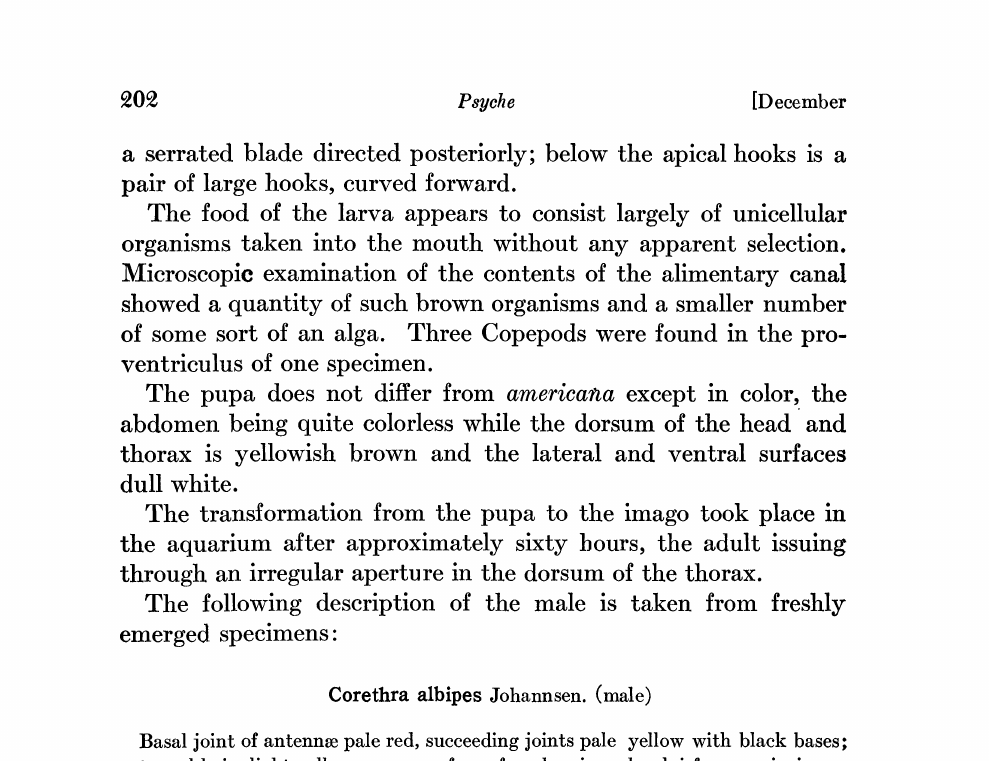
Corethra albipes ;lohannsen. (male) Basal joint of antennae pale red, succeeding joints pale yellow with black bases; antennal hairs light yellow, upper surface of proboscis and palpi fuscous; incisures of palpal joints not lighter; cheeks yellowish white; ocellar space brown. Ventral surface of proboscis fuscous. Thorax pale brown dorsally with three reddish brown longitudinal stripes, the median stripe with a piceous median line and piceous lateral borders, the lateral stripes with piceous lateral borders only; the median stripe is produced anteriorly and abbreviated posteriorly, the lateral stripes are abbreviated anteriorly and produced posteriorly; plure dull white with a pale brown suffusion, spotted with piceous; scutellum pale brown with a black median line and an irregular black spot on each lateral angle; metathorax pale brown, peppered with darker spots. Ventral surface of thorax yellowish white. First and last abdominal segments smallest, others nearly equal; ground color of dorsal surface pale yellow marked with piceous, the markings being heaviest on the anterior part of the segments; sometimes a more or less well-defined anterior median spot and a darker anterior lateral spot on each segment. Hypopygium consisting of two jointed hooks, dark brown in color and about as long as the last abdominal segment. Ventral surface of abdomen with an irregular black spot on either side of the median line. Legs pale yellow, the last three tarsal joints dark- ened. Wings pale yellow, the veins clothed with long yellow hair; hair is also present on the wing margins, reaching its greatest development on the posterior margin; hair on posterior margin in two rows, one about half the length of the other; longest row composed of very wide hairs (see fig. 2 1). Halteres white. Length of two specimens 7 ram. and 6.5